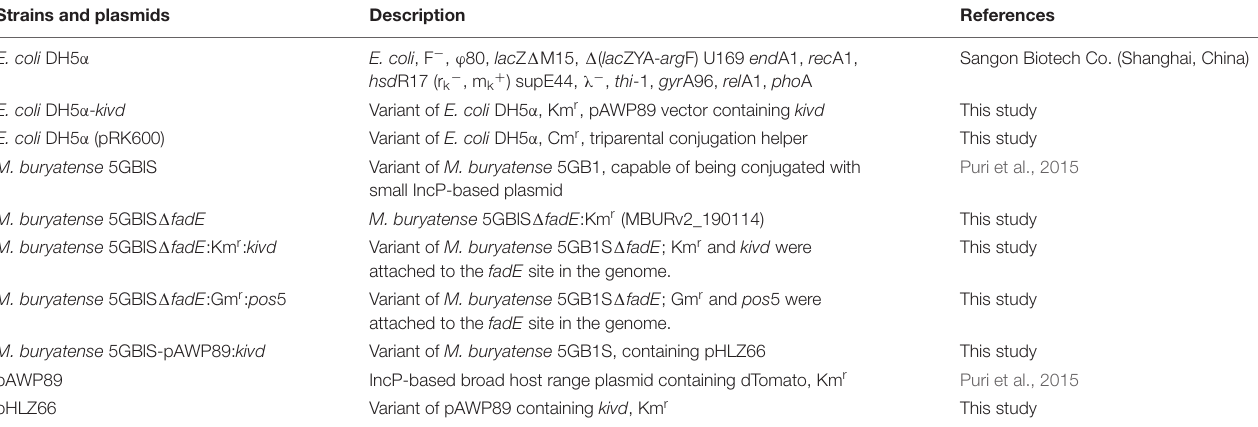
TABLE 1 | List of the strains and plasmids used in the study. Strains and plasmids